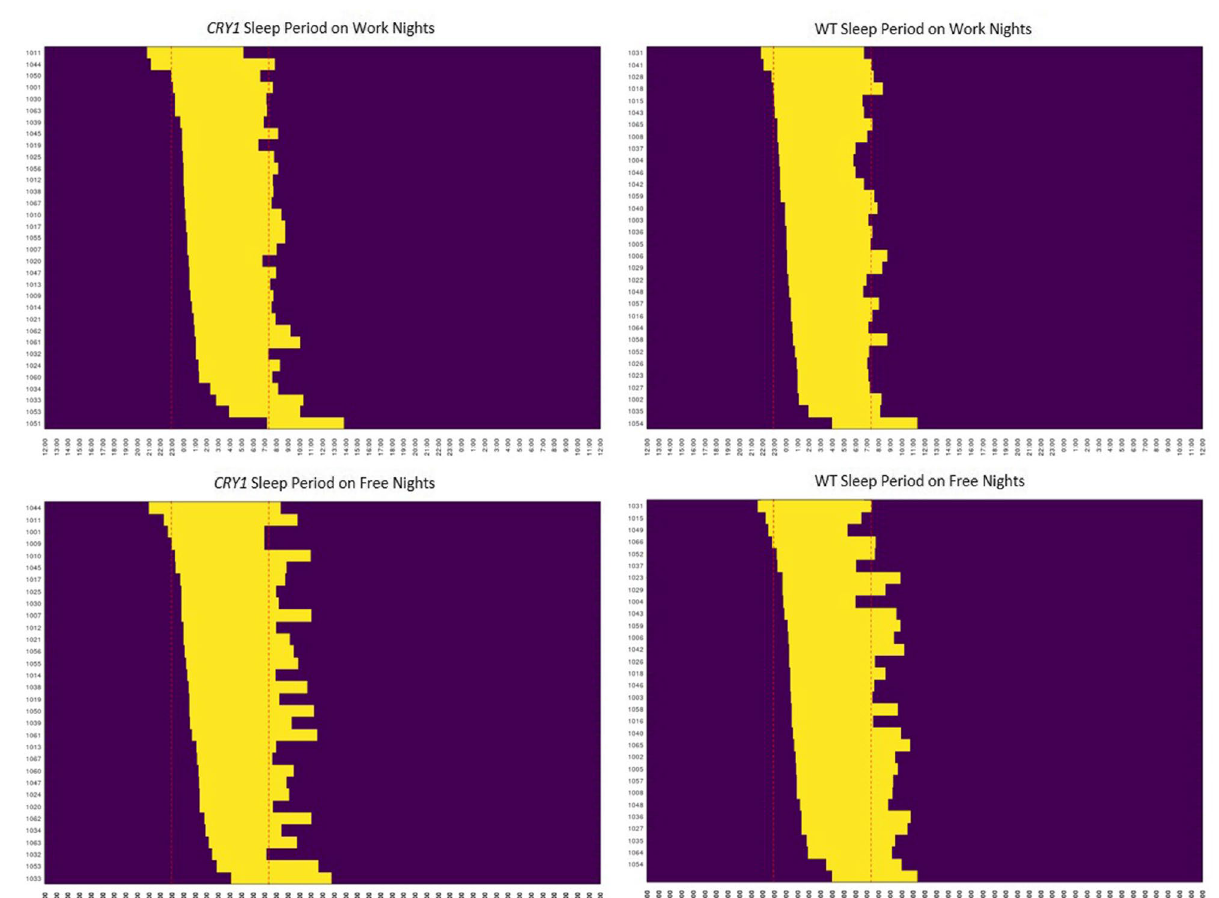
Figure 3. Visualization of the sleep diary data for free night (without obligation on the next day) and work nights (necessity to work in the morning) for the CRY1Δ11 variant group (n = 33) compared to WT controls (n = 34) sorted by bed